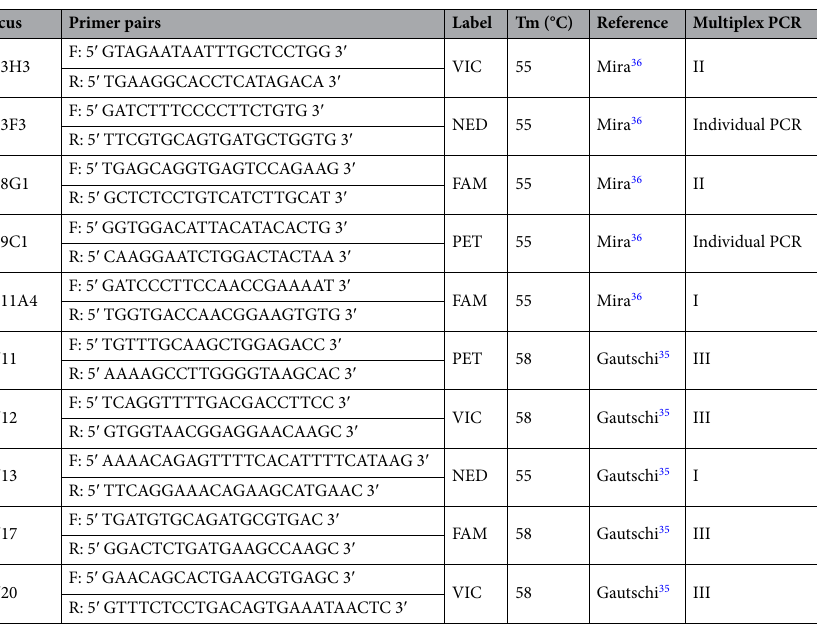
Table 4. List of loci used in genetic analyses, primers used for their amplification, fluorescent dyes used for tagging the forward primers, annealing temperature (Tm) used in each reaction for the amplification of specific microsatellite loci with the combination of loci amplified together in multiplex reactions I, II, III, and individual